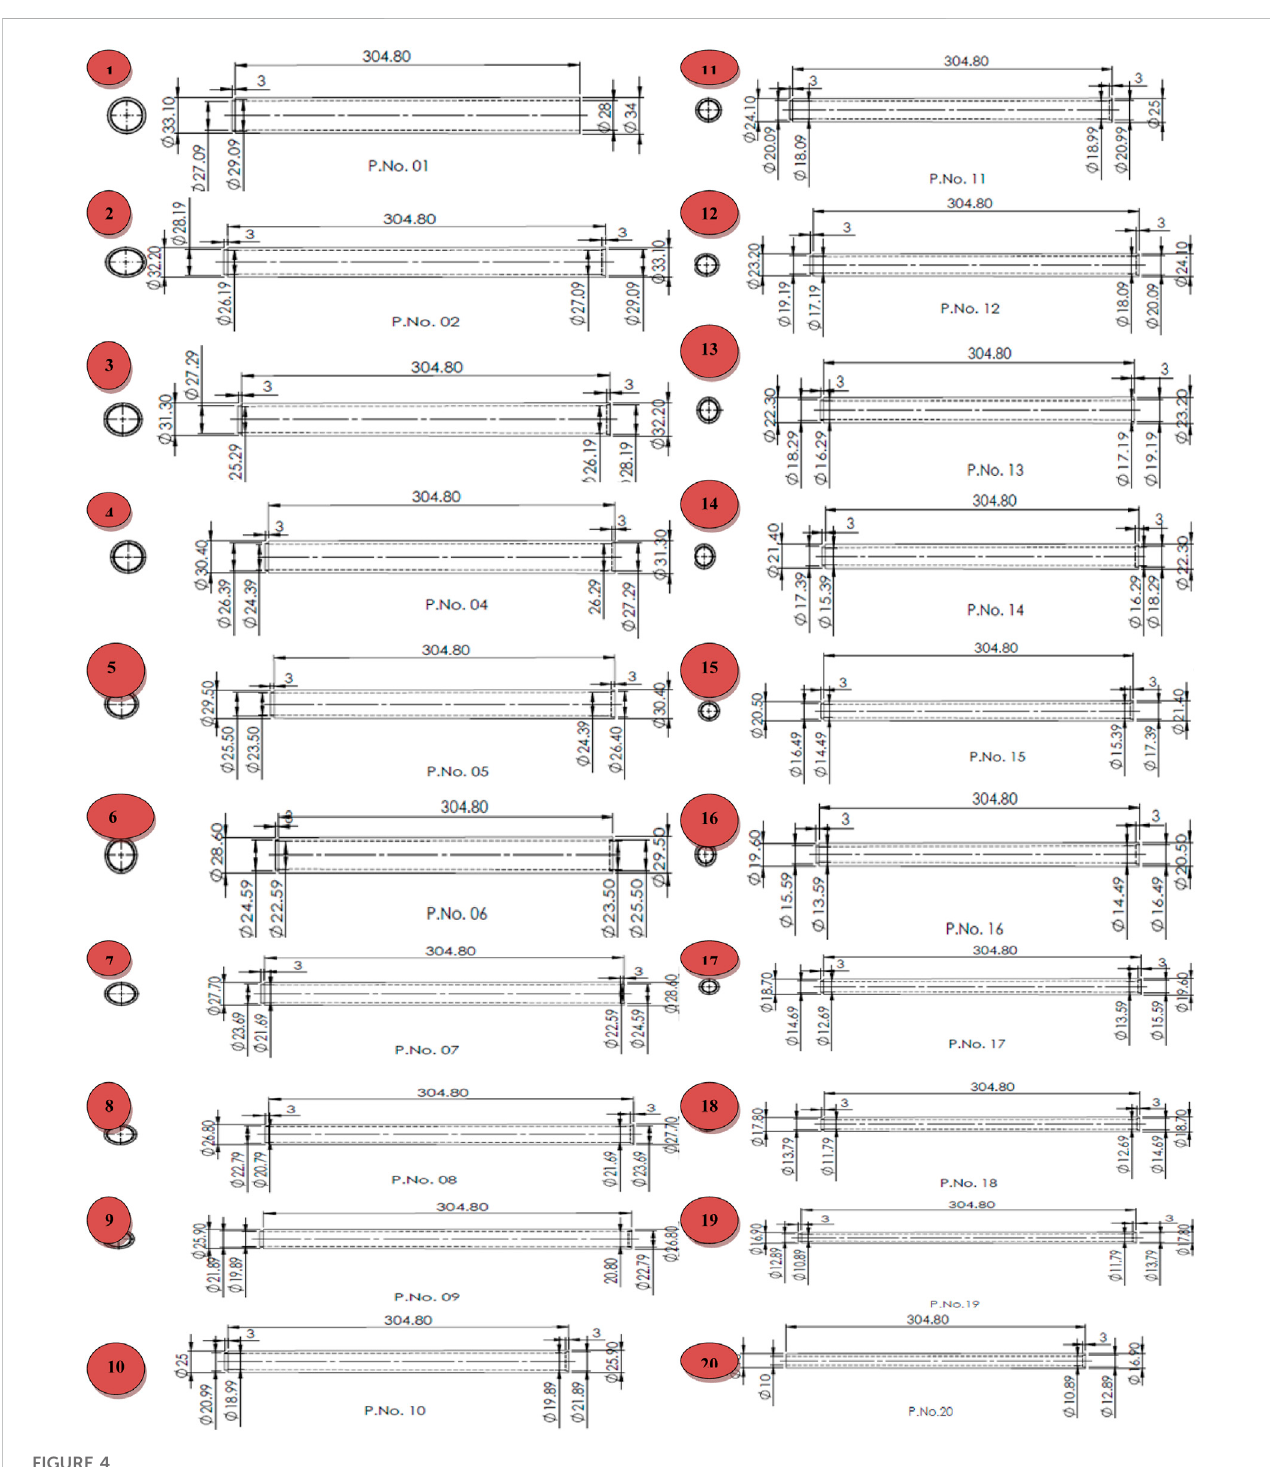
Detailed design of the 20 pieces of the